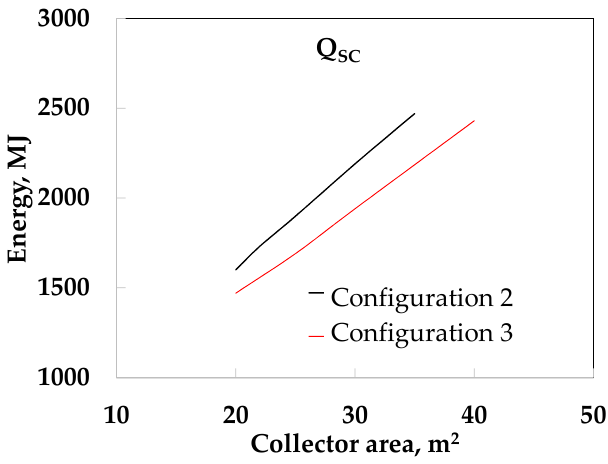
Figure 16. Solar energy against solar collector area at LHST volume of 0.75 m 3 .